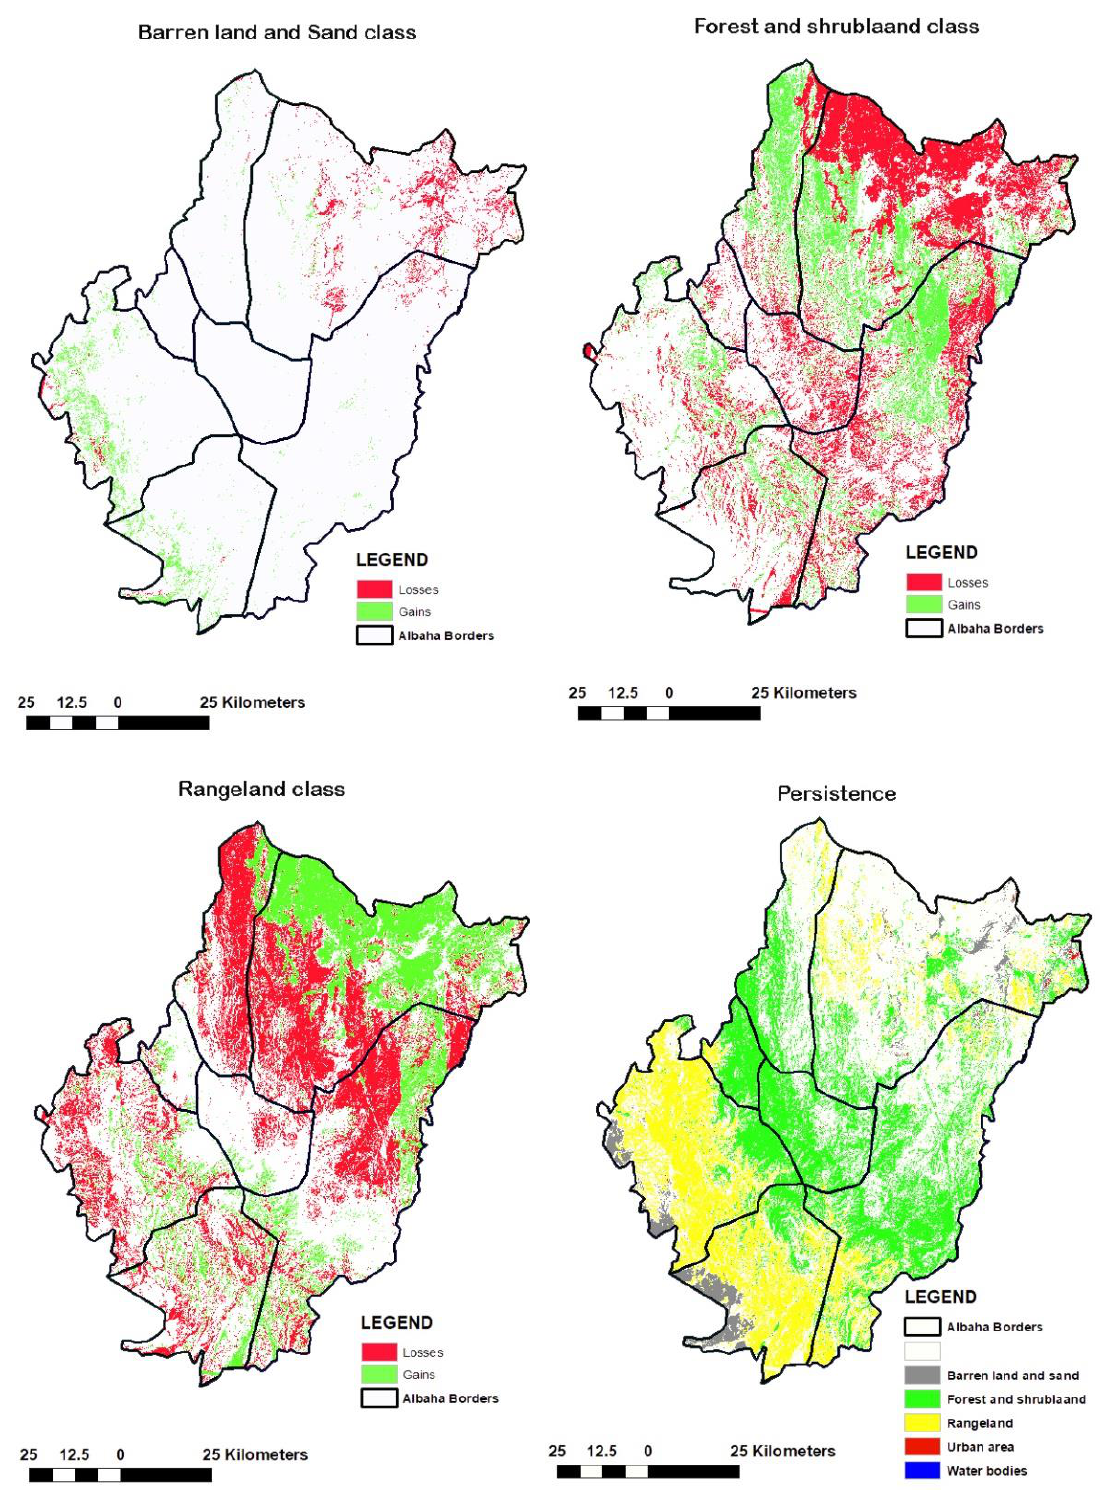
Figure 11. Spatial mapping of gains, losses and persistence of various land cover of El Baha region between 1985 – 2021.